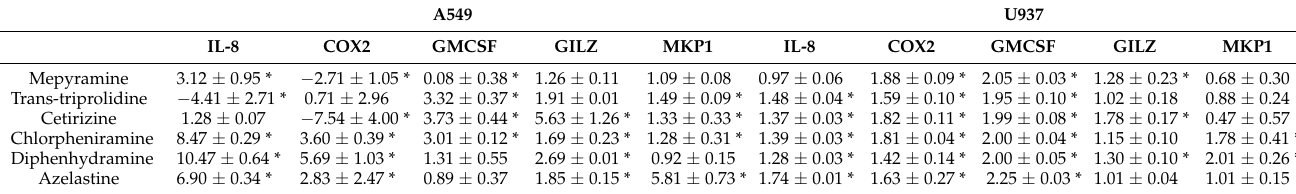
Table 1. Effect of antihistamine on the dexamethasone-induced expression of inflammation-related genes. A549 U937 IL-8 COX2 GMCSF GILZ MKP1 IL-8 COX2 GMCSF GILZ